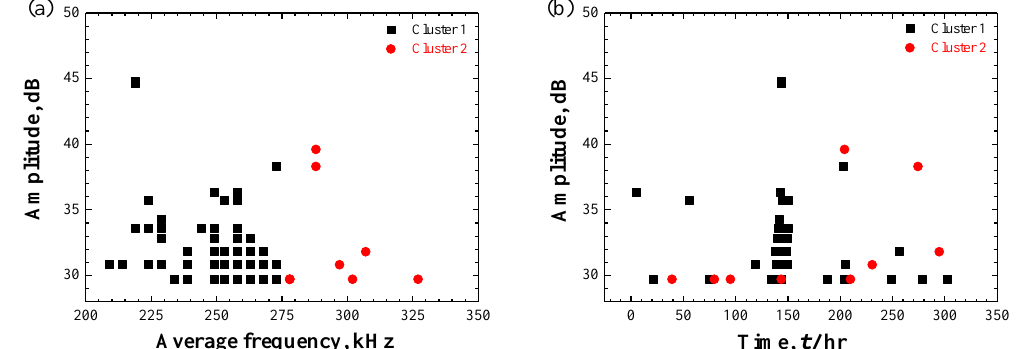
Figure 11. ( a ) The result of AE clustering analysis with two clusters; ( b ) Evolution of cluster 1 and 2 during localized corrosion in specimen A. Online version in color.